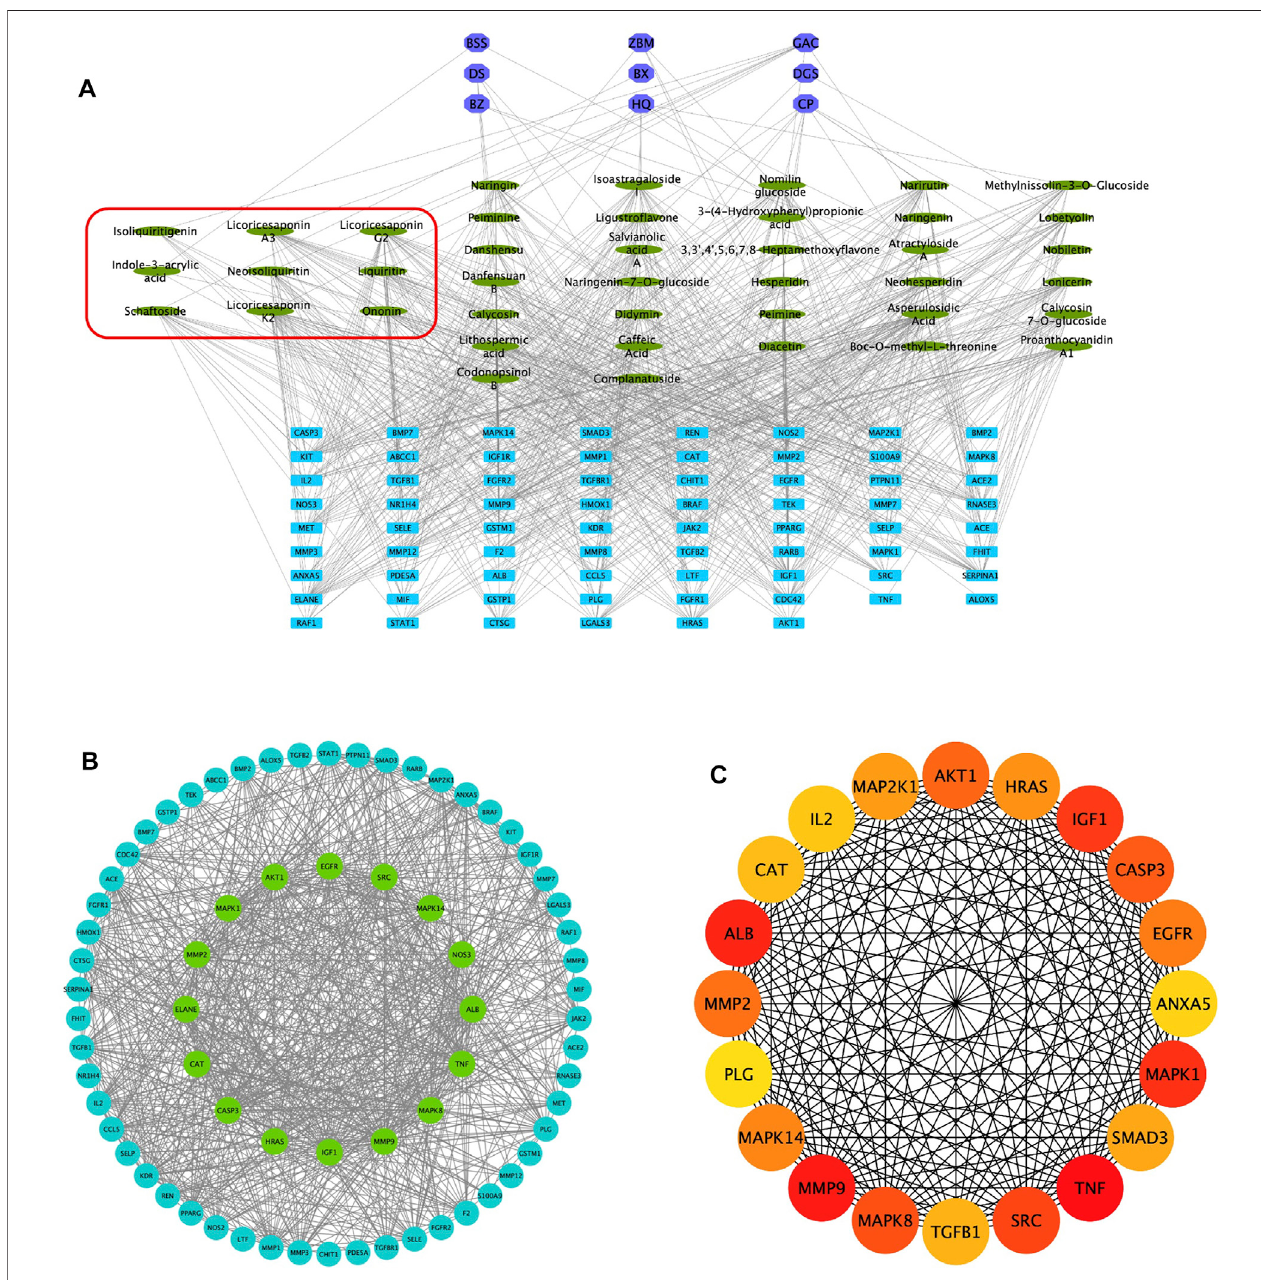
FIGURE 2 | Potential targets of QM components were predicted by network pharmacology analysis. (A) Construction of the network of 43 components – 70 overlapping targets – nine botanical drugs. The green ovals represent the 43 active ingredients, the purple octagons represent the nine Chinese medicines, and the blue rectangles represent the 70 targets. The components circled by the red box are active ingredients isolated from rats ’ plasma. (B) Construction of the protein – protein networktoidentifypotentialtargetsofQM.Theblueandgreencirclesrepresenttheoverlappingtargets.Topologicalanalysiswasusedtoscreenmorecoretargets of QM, according to degree ≥ 24, betweenness ≥ 0.01, and closeness ≥ 0.615, which are represented by the green circles. (C) The top 20 target networks are shown.